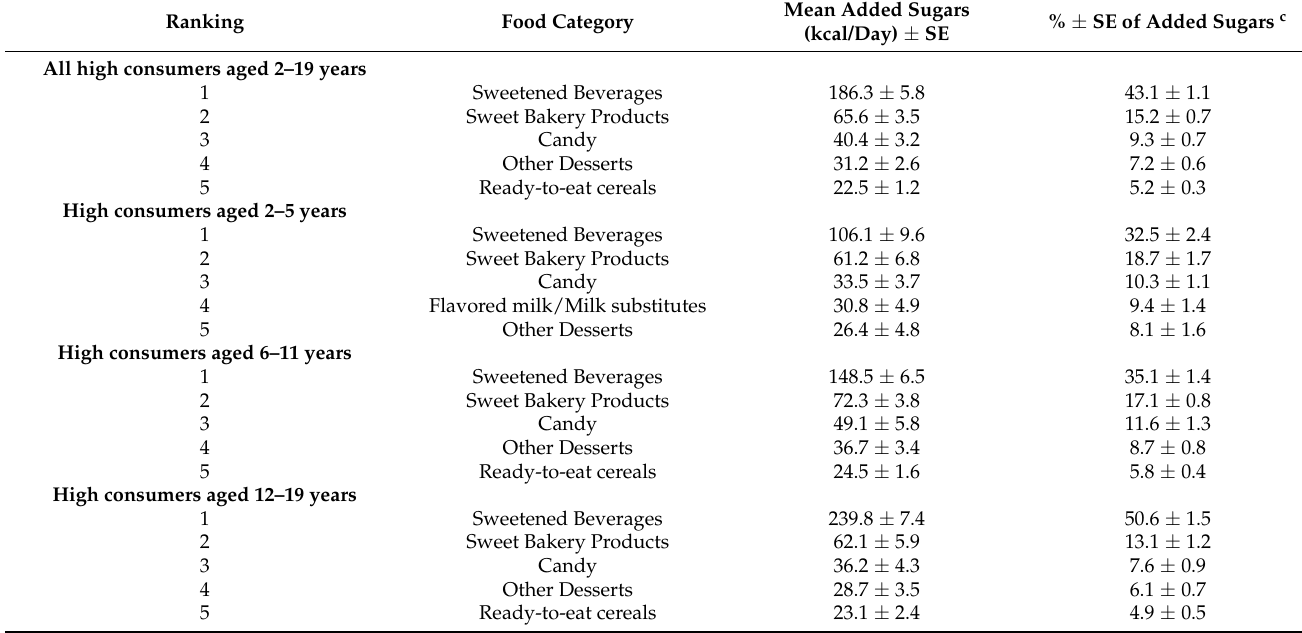
Table 3. Top five sources of added sugars and mean calorie intake from top five sources among high consumers of added sugars a aged 2–19 years, overall and by age, NHANES 2015–2018, on a given day (based on Day 1 dietary recall ( n = 2144)) b